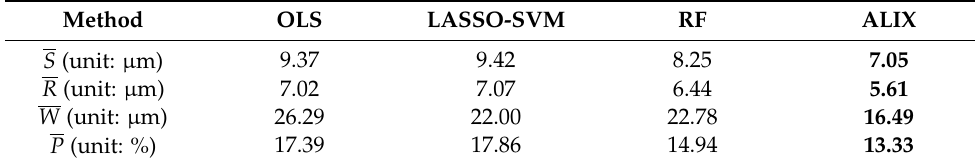
Table 5. Average values of S k , R k , W k , and P k over all 23 models for each method.